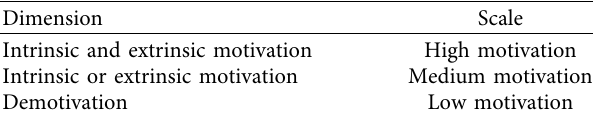
Table 5: Scale for the motivational dimensions. Dimension